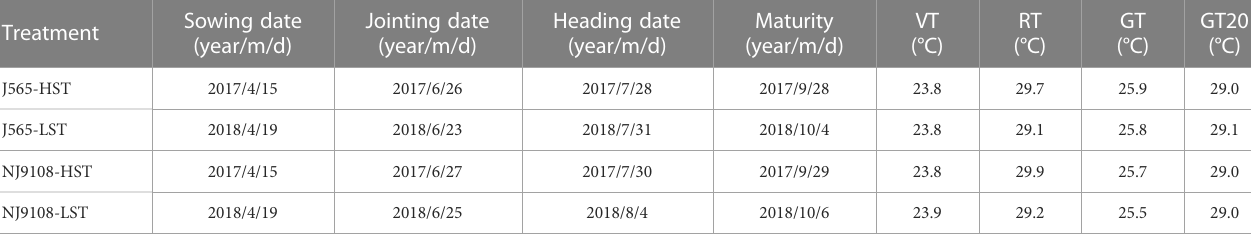
TABLE 1 Growth duration and mean temperature during different phenological stages in different situations. Treatment